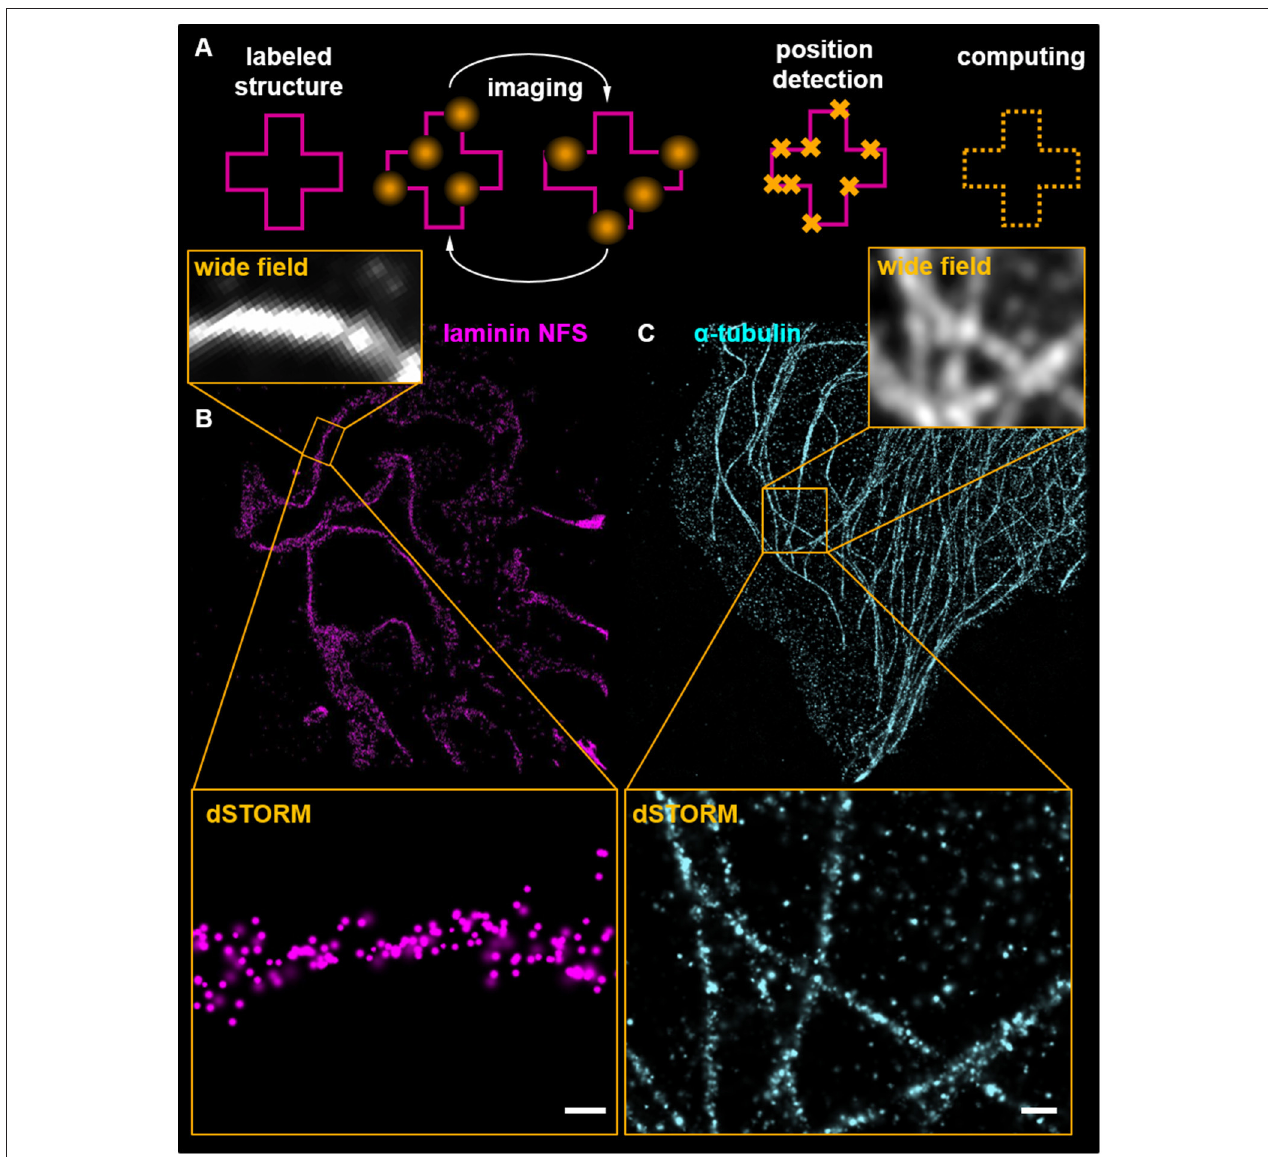
FIGURE 4 | Scheme (A) presents the basic principle of localization microscopy. Labeled structures are cyclically imaged and positions of individual fluorophores calculated. For further explanations see the main text. (B) shows a dSTORM image of a murine glomerulus labeled with an antibody for the glomerular basement membrane component laminin detected by secondary antibodies conjugated to Alexa Fluor 647. Ten thousand imaging cycles were recorded in the presence of a redox buffering system containing 2-mercaptoethylamine and in absence of oxygen accomplished by glucose oxidase and catalase. Superresolution is demonstrated in comparison with the corresponding WF picture. The scale bar indicates 200nm in the magnification. (C) shows the microtubule cytoskeleton of a murine cultured podocyte detected by anti α -tubulin antibodies. The magnification demonstrates localizations of individual antibodies on microtubules. The scale bar indicates